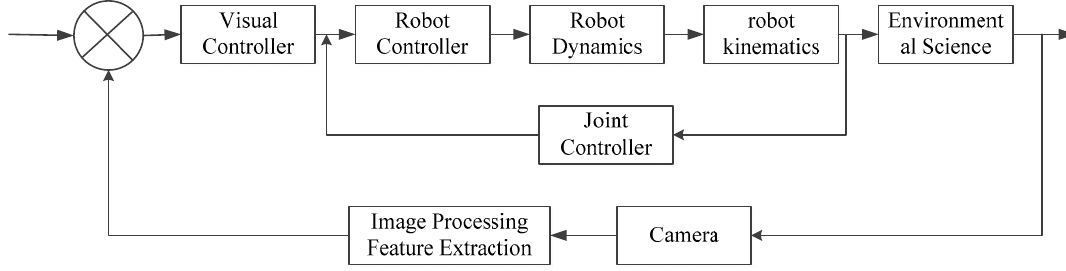
Figure 7. Image-based visual servo system structure.